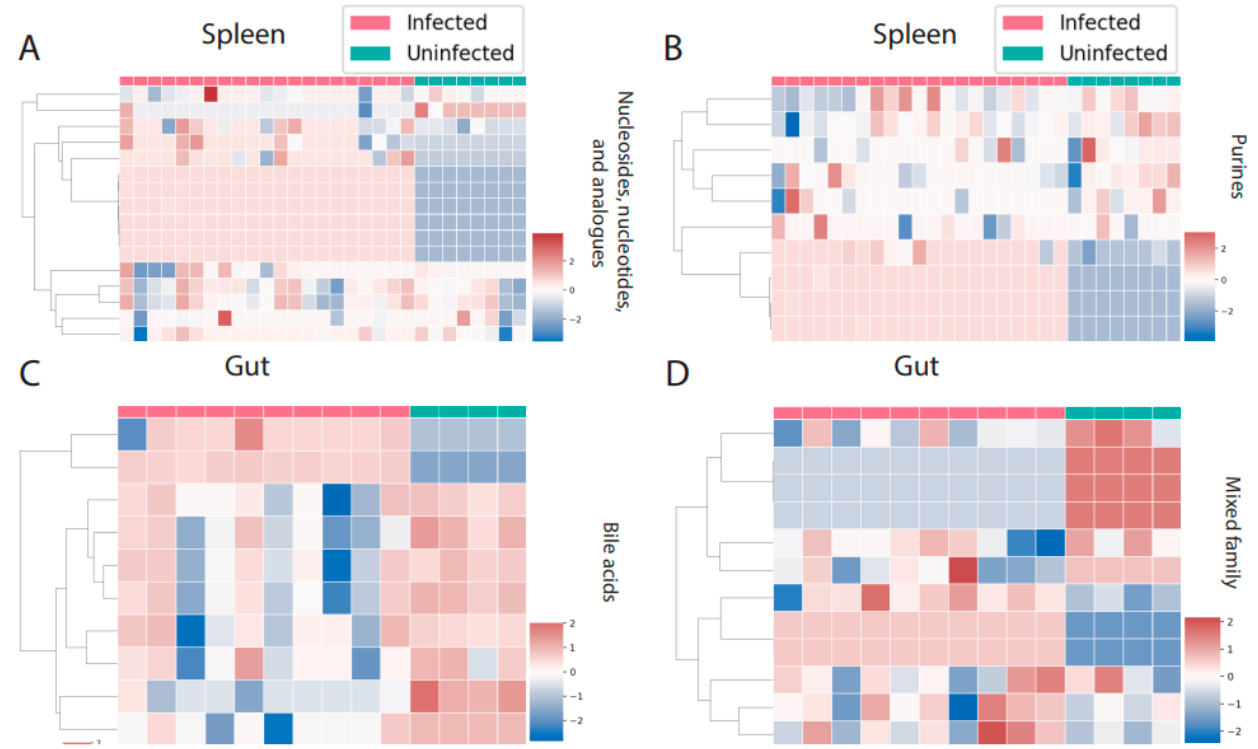
Figure 5. Perturbed chemical families specific to one organ. ( A , B ) Nucleosides, nucleotides, and analogues and purines are the perturbed chemical families that are specific to the spleen. ( C , D ) Bile acids and a mixed family are the two families that were perturbed by infection only in the gut. Infected samples are shown in red and uninfected samples in green. Each column represents one sample, and each row represents one metabolite feature. Scale shows zero mean and unit variance (higher than zero mean = red and lower than zero mean = blue color) at each row.